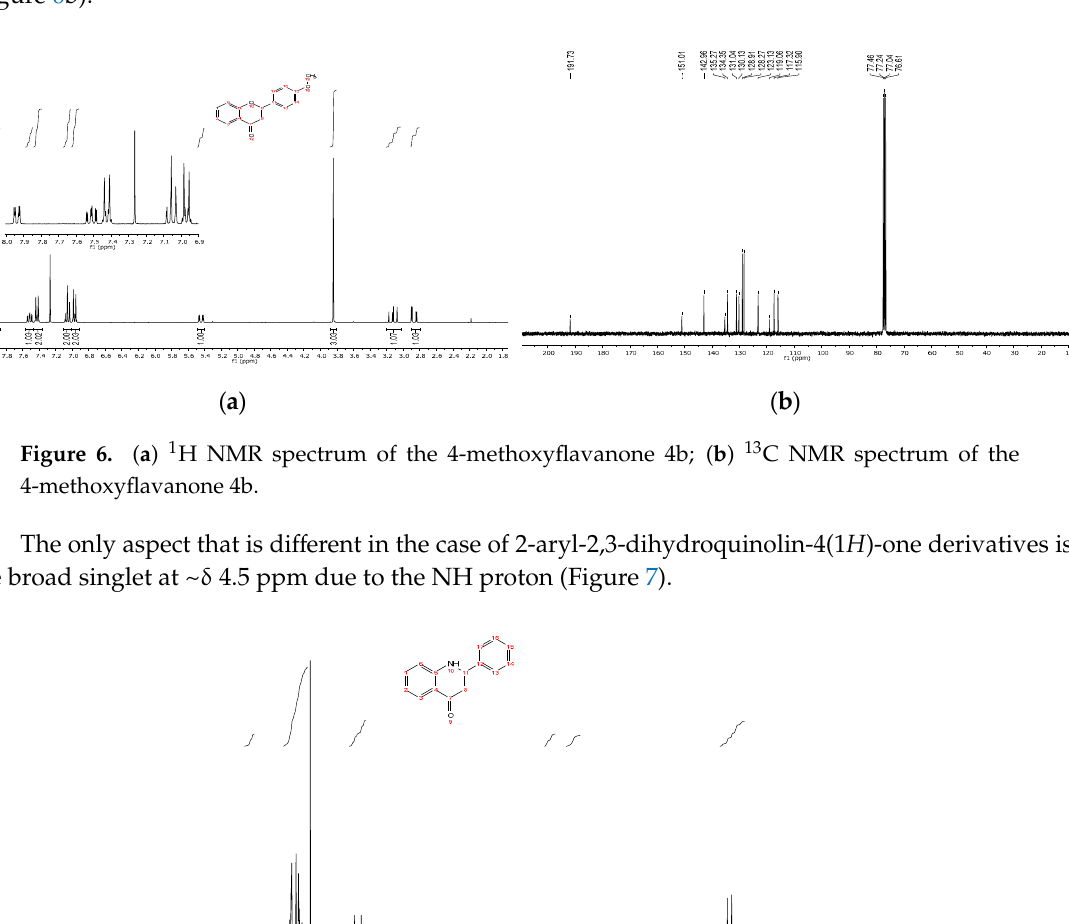
Figure 7. 1 H NMR spectrum of 2-aryl-2,3-dihydroquinolin-4(1 H )-one 4d.